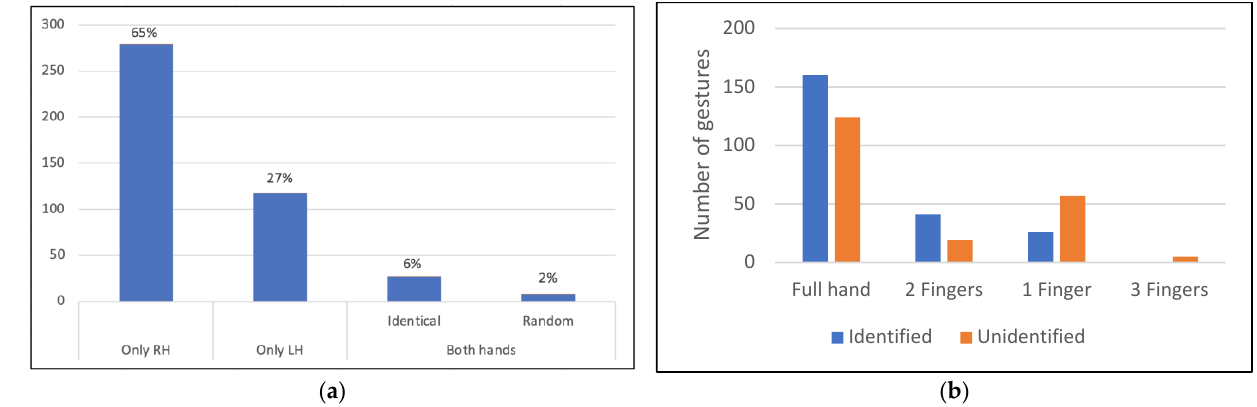
Figure 3. ( a ) The number and percentage of gestures employed by one or two hands; ( b ) the number of identified and unidentified gestures in accordance with the gesture vocabulary proposed in [10].